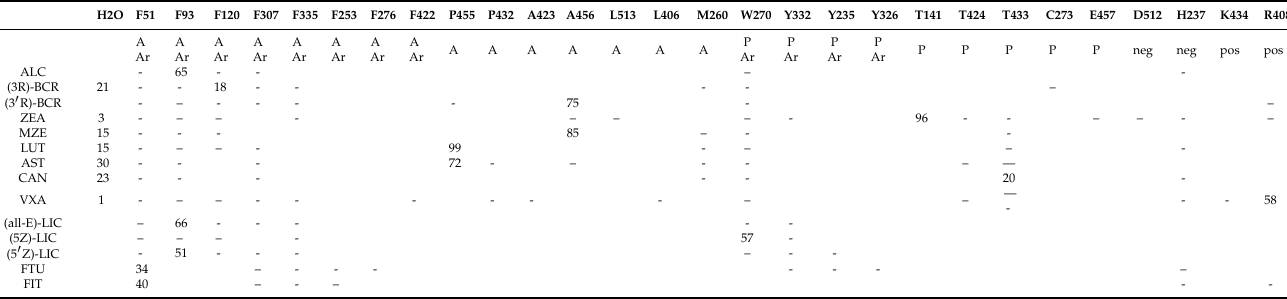
Table 5. Fingerprint analysis for BCO1. The first row lists the individual residues (one-letter coding). The second row describes the nature of the residues: A = non-polar; AAr = non-polar aromatic; P = polar; PAr = polar aromatic; neg = negatively charged; pos = positively charged. ALC = α -carotene; BCR = β -cryptoxanthin; ZEA = (3 R ,3 (cid:48) R )-zeaxanthin; MZE = (3 R ,3 (cid:48) S , meso )- zeaxanthin; LUT = (3 R ,3 (cid:48) R )-lutein; CAN = canthaxanthin; AST = (3 S ,3 (cid:48) S )-astaxanthin; VXA = (3 S ,3 (cid:48) S )- violaxanthin; LIC = lycopene; FTU = (15 Z )-phytofluene; FIT = (15 Z )-phytoene. For all carotenoids, the protein residues with which interaction is found at least once during production are marked with a cross. Each cross represents the interaction of each atom interacting with the amino acid residue. In the cases of interaction with the solvent, the number of water molecules with which the ligand interacts is reported (coordination waters with Fe 2+ are not considered). The numbers in the third column express the percentage of interaction between the residue (columns) and the carotenoid (rows); in all cases, two crosses should also be marked (omitted) except for (3 R )-BCR and AST, for which only one atom of the ligand interacts with the highest percentage